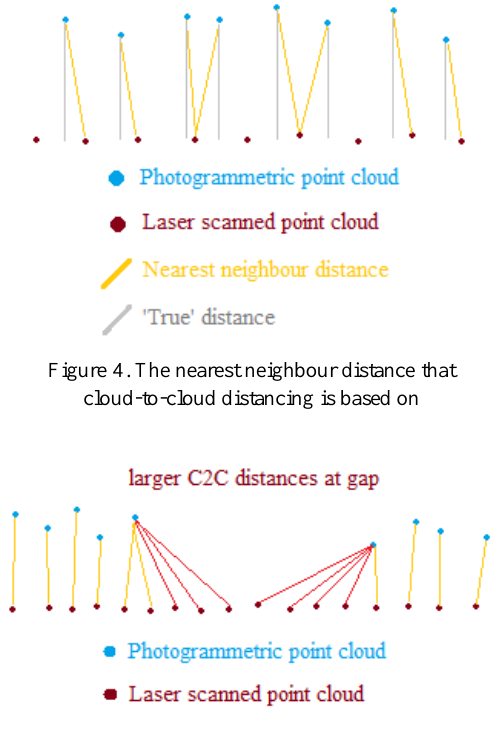
Figure 5. Measuring C2C distances from the laser scanned point cloud will capture gaps in the photogrammetry model Figure 6. C2C distances of different software. Clockwise from top-left: ContextCapture, Photoscan, VisualSfM, MicMac. Red indicates 5cm and above